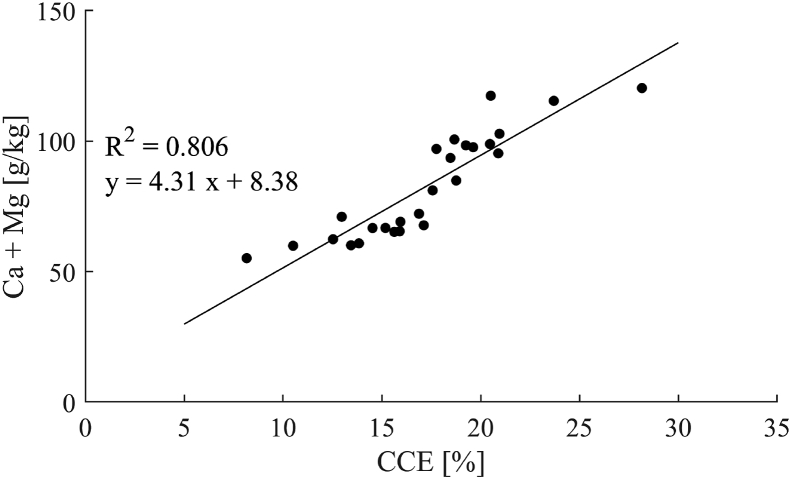
Relationship between CCE and cumulative Ca and Mg concentrations of all studied biochars.